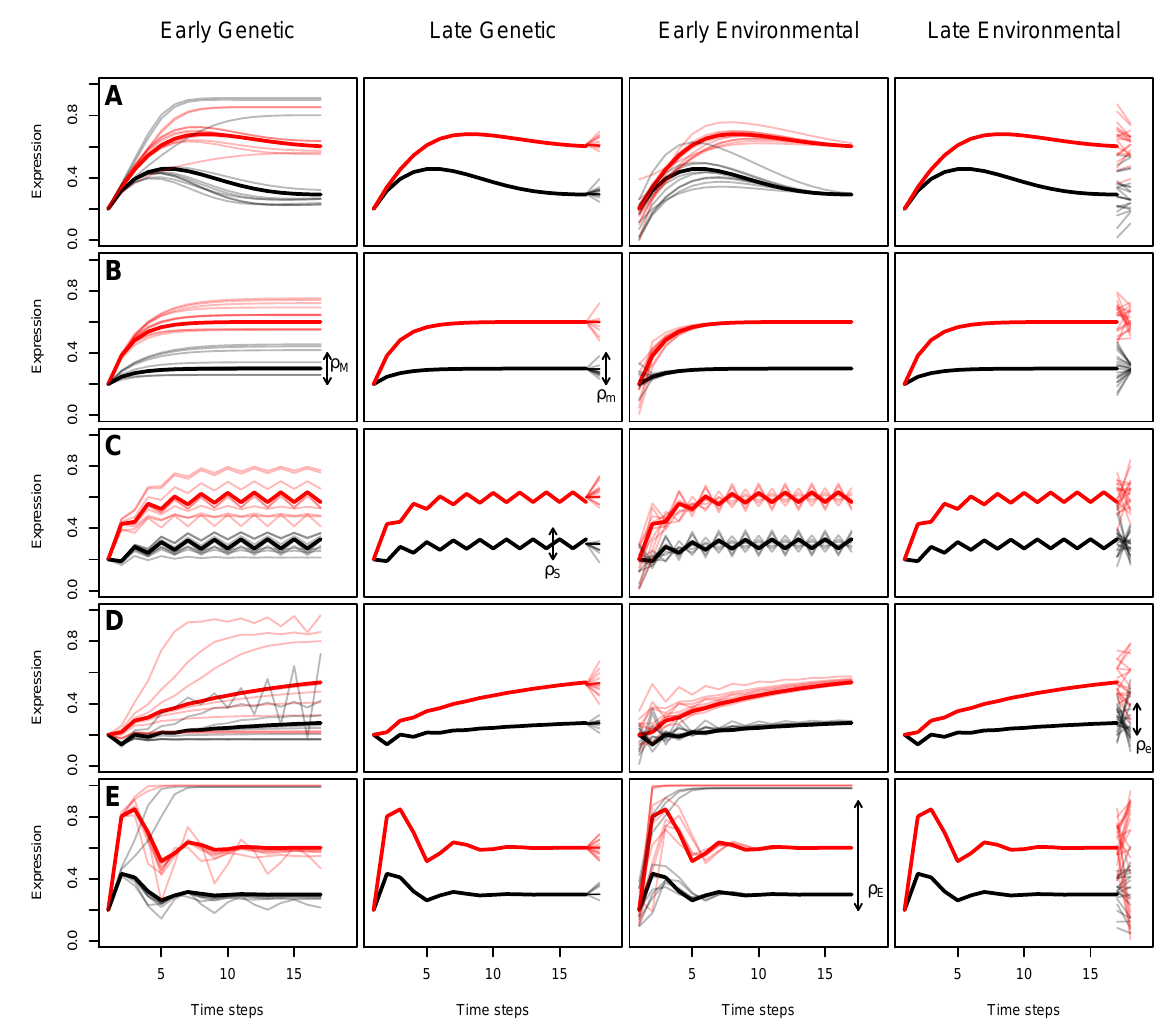
Figure SI6 – Illustration of the robustness scores. The figure displays a subset of the replicated tests for four robustness indexes. Rows A to E correspond to the five net- works described in Sup. Figure SI5. Four (out of five) robustness measurements rely on a resampling procedure (corresponding to the four columns of the figure). In each panel, the default (undisturbed) network kinetics is displayed as plain lines (black for gene 1, red for gene 2), while 10 disturbed networks are indicated as pale lines. By construction, all networks have an equilibrium at (0.3, 0.6). The network stability can be assessed from the amplitude of the cycles in the undisturbed kinetics (thick lines), and does not rely on a stochastic algorithm. The network robustness to genetic disturbance was estimated by mutating the gene network before the first time step (early genetic mutation, first column) or before the last time step (late genetic mutation, second column). Environmen- tal robustness was estimated by disturbing the gene expression, without changing the genotype, before the first time step (early environmental, third column) and before the last time step (late environmental, fourth